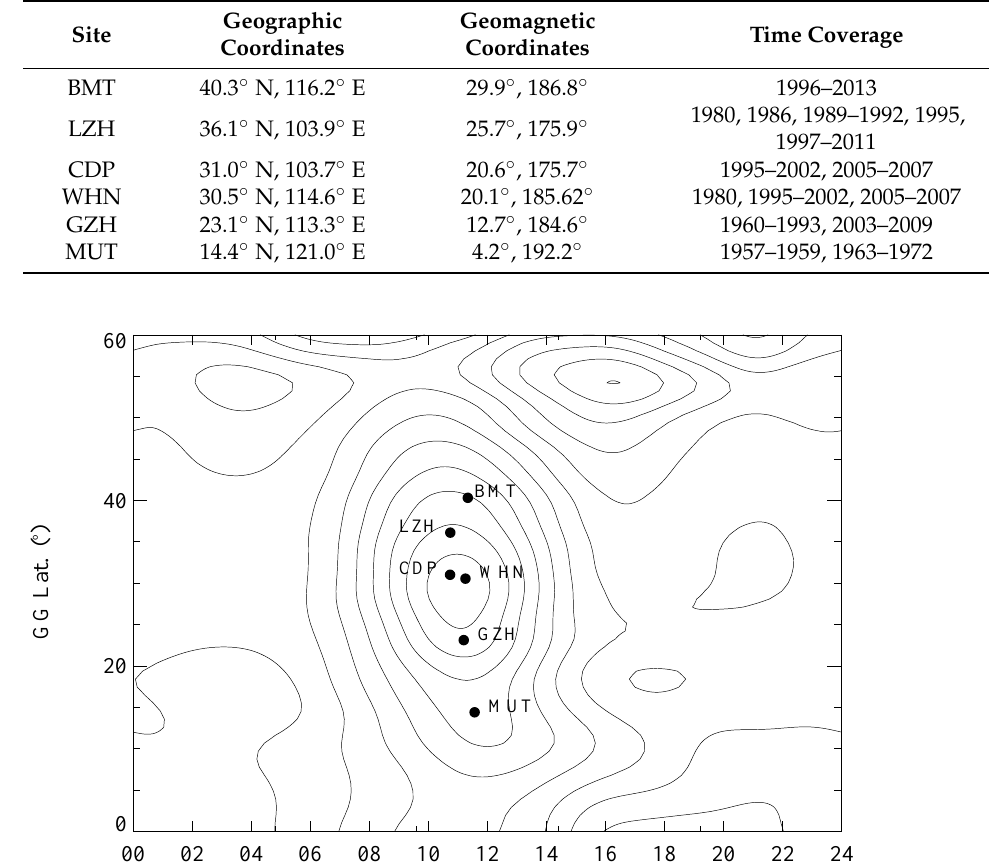
Table 1. Coordinates and time coverage of the geomagnetic observatories used in this study.